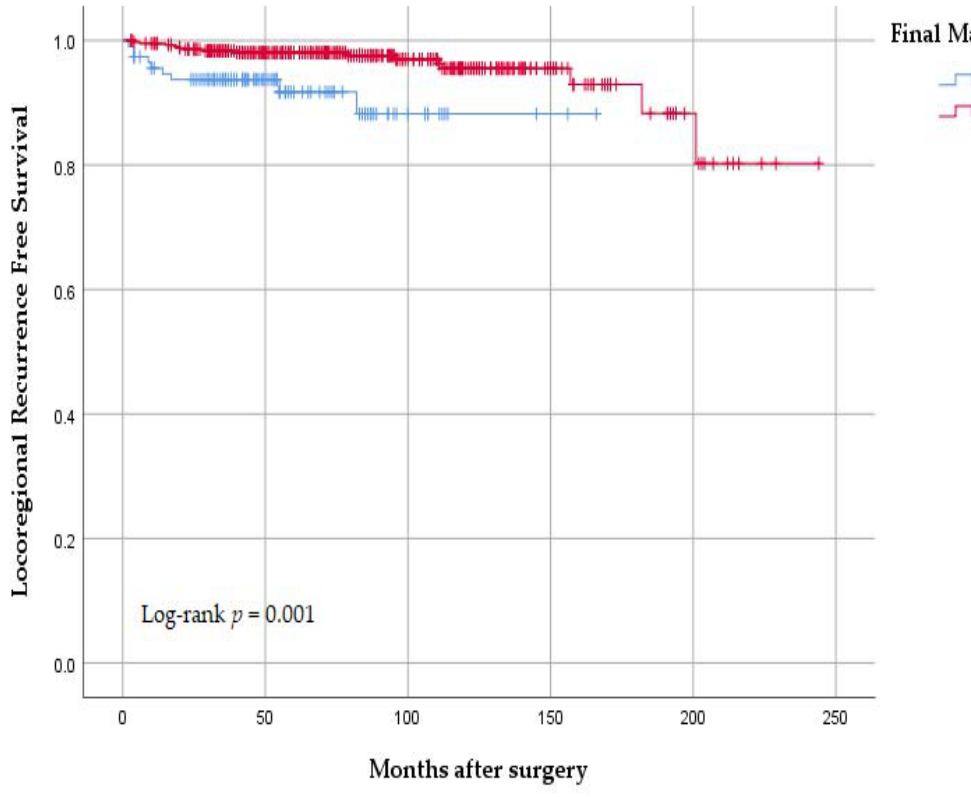
Figure 2. Locoregional recurrence ‐ free survival according to final margin status after definitive surgery.